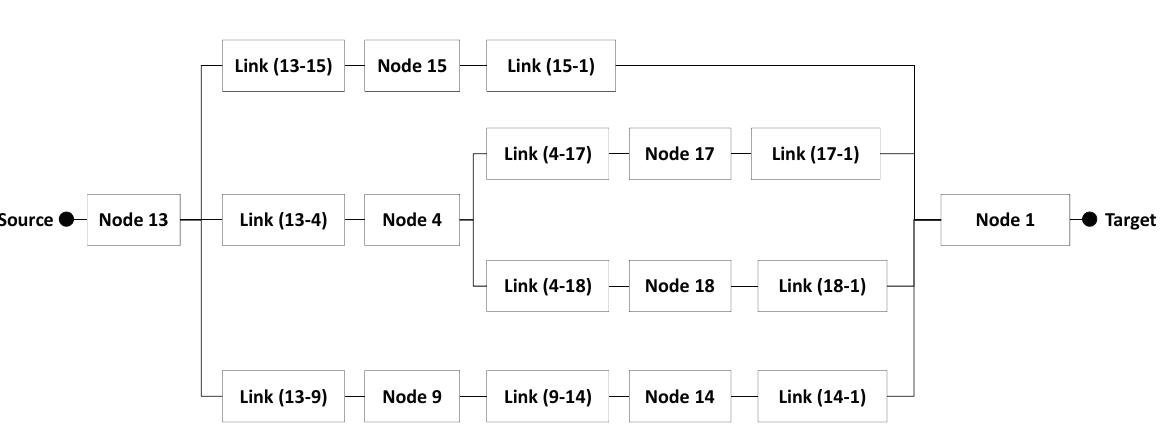
Figure 14. Region Model when the WSN uses the FLOODING